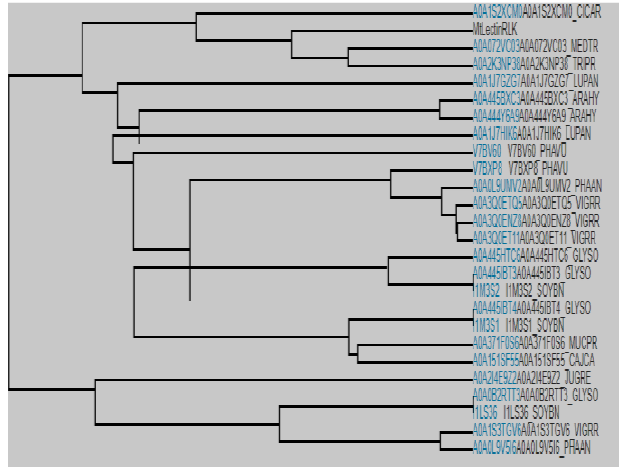
Figure 7 . The predicted Medicago truncatula MtLectinRLK is ancestry related to probable L-type lectin-domain containing receptor kinase VII.2. Phylogenetic tree was constructed using EMBL-EBI